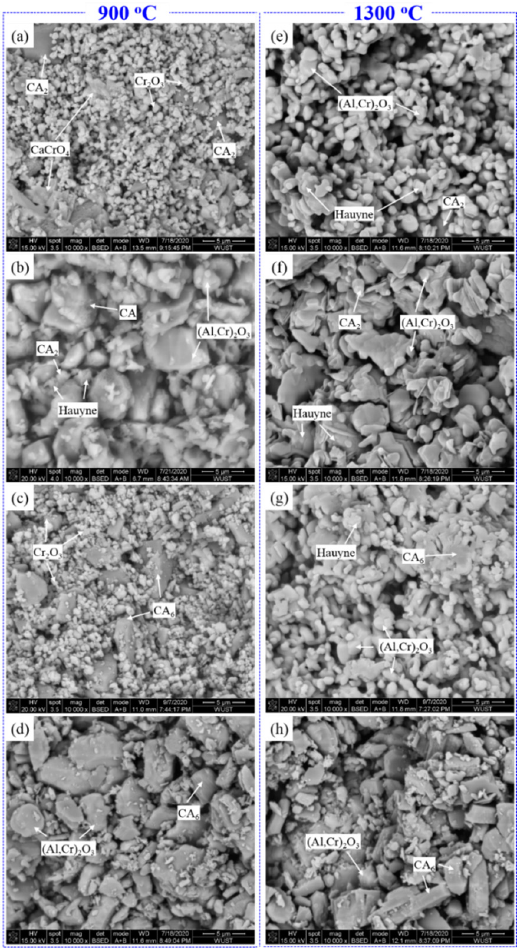
Figure 5. SEM images of cylindrical specimens heated at 900 °C and 1300 °C, ( a , e ) C-C; ( b , f ) C-S; ( c , g ) CH-C; ( d , h ) CH-S.